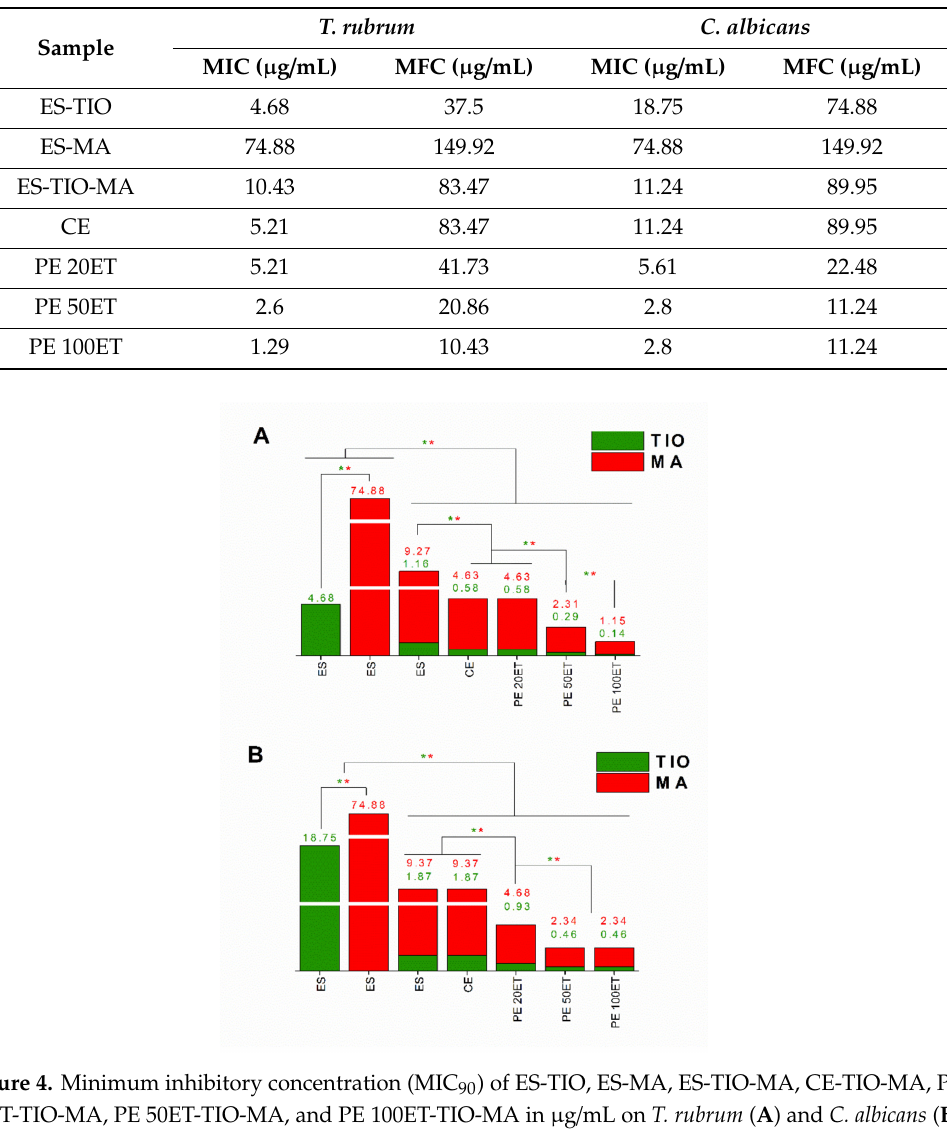
Table 5. Minimum inhibitory concentration (MIC) and minimum fungicidal concentration (MFC) of the test samples in combinations on T. rubrum and on C. albicans.